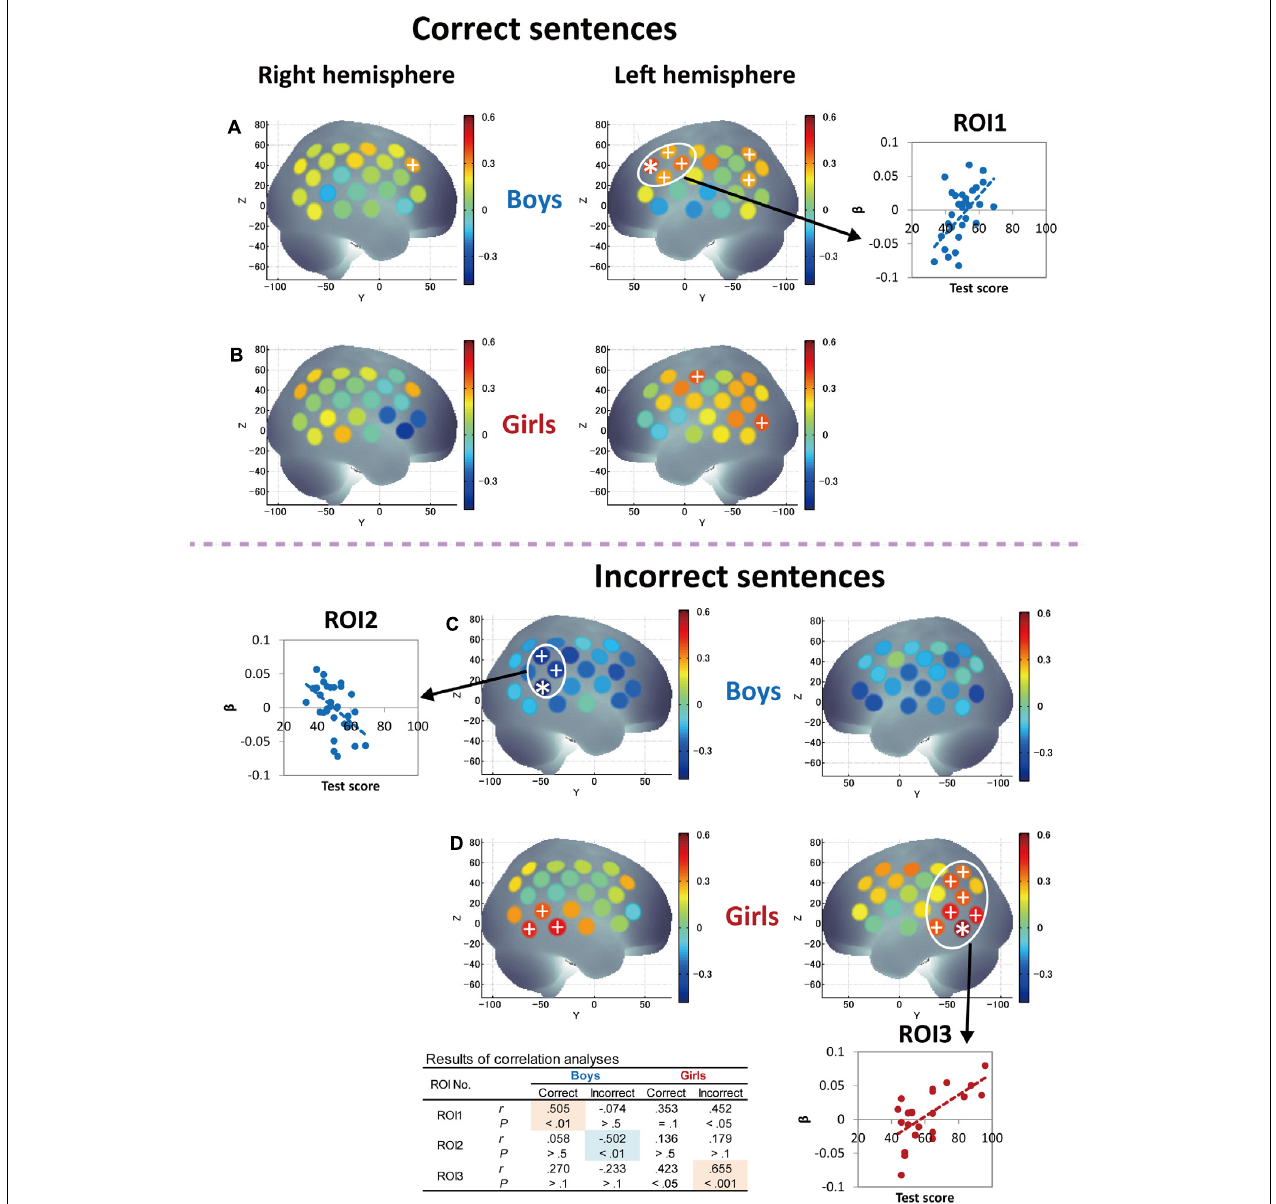
FIGURE 5 | Correlations between grammar listening test scores and cortical activation during correct-sentence processing [boys (A) and girls (B) ] and incorrect-sentence processing [boys (C) and girls (D) ]. Colored bars represent Pearson’s correlation coefficient. Asterisks depict channels that showed a significant correlation between test score and cortical activation after Bonferroni correction using the Dubey/Armitage-Parmar (D/AP) alpha boundary to take into account the spatial correlation of 44 measurement channels. We set the statistical threshold of fNIRS analysis at 0.005. In order to consider the spatial extent of cortical activation, we defined ROIs that consisted of single or multiple core channels which fulfilled the determined threshold (0.005) and adjacent channels that satisfied a secondary threshold of P < 0.05, which are depicted with plus signs. The average activation of the nearest-neighboring significant channels satisfying the above threshold was calculated for each ROI, and graphs showing the correlations between test score and cortical activation are displayed. The table at the bottom shows the statistical results of correlation analyses (Pearson’s correlation coefficients, r and P -values) for each ROI so that the trends of similarities and/or differences in the relationships between Grammar_L scores and cortical activation can be compared between sexes, as well as between correct- and incorrect-sentence